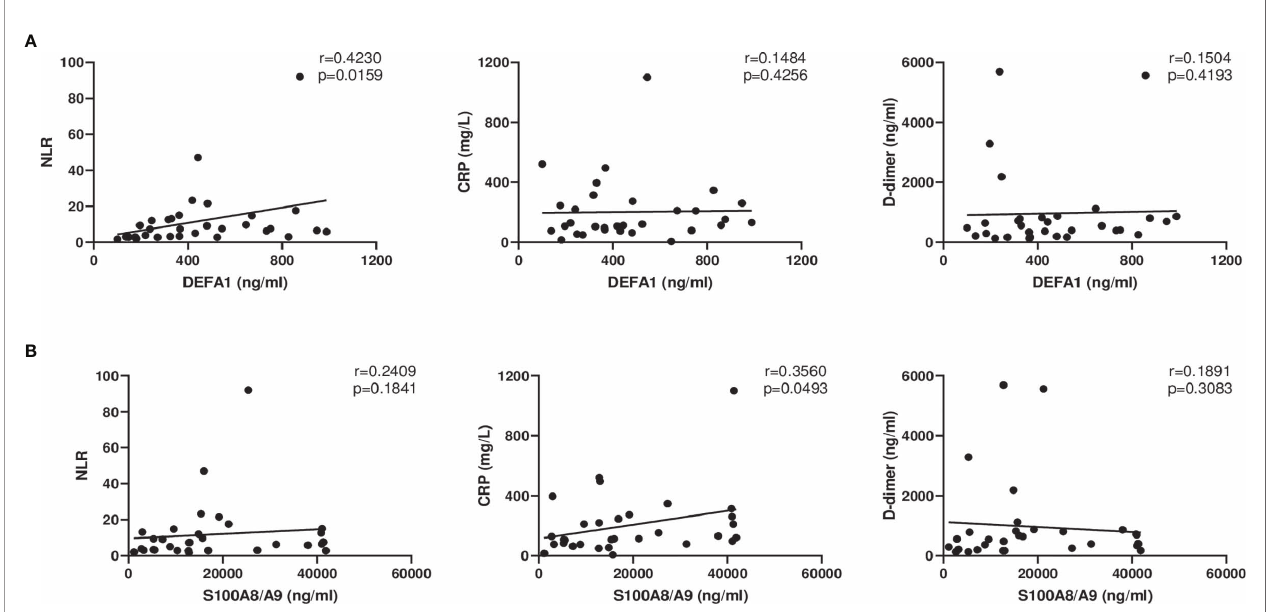
FIGURE 4 | Correlation analyses between levels of DEFA1 and S100A8/A9 with clinical laboratory parameters in COVID-19 patients with severe disease at the time of admission. (A) DEFA1 levels compared with Neutrophil to Lymphocyte Ratio (NLR), C reactive protein (CRP), D-dimer levels. (B) Levels of S100A8/A9 compared with NLR, CRP and D-dimer levels. Spearman ’ s correlation coef fi cient was calculated for each